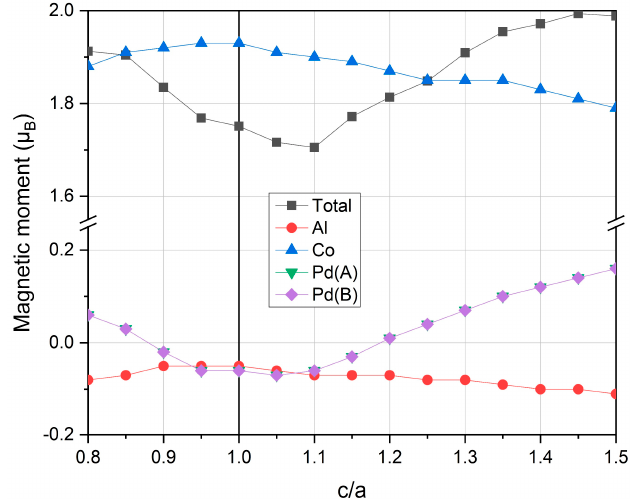
Figure 9. The calculated total and atom-resolved magnetic moments for the full Heusler compound Pd 2 CoAl in L2 1 -type structure under different tetragonal strains. Note the different scale of the two parts in the vertical axis.